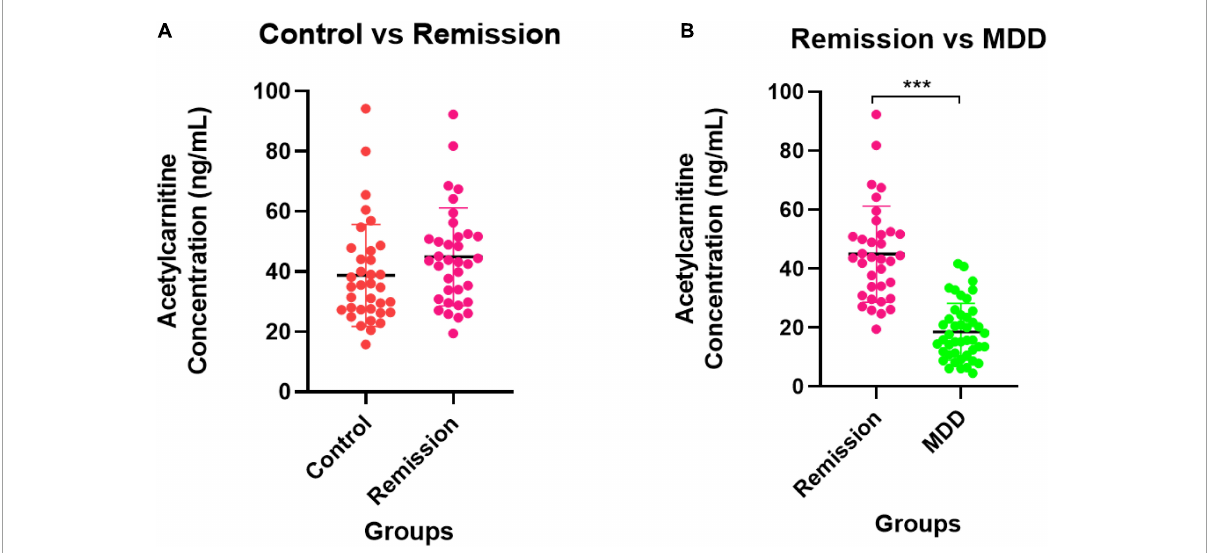
FIGURE6 Validation for remission state of MDD patients. (A) The comparison of acetylcarnitine concentration between the control group and the remission group. (B) The comparison between the remission group and the MDD group. The control group is indicated by a red dot, the MDD group by a green dot, and the remission group by a pink dot. After the Shapiro–Wilk normality test, a difference test was performed through the Mann–Whitney test. The schematic and statistical work was performed using GraphPad Prism software (version 8.4.2). The values in the graph represent mean ± SD. *** P <